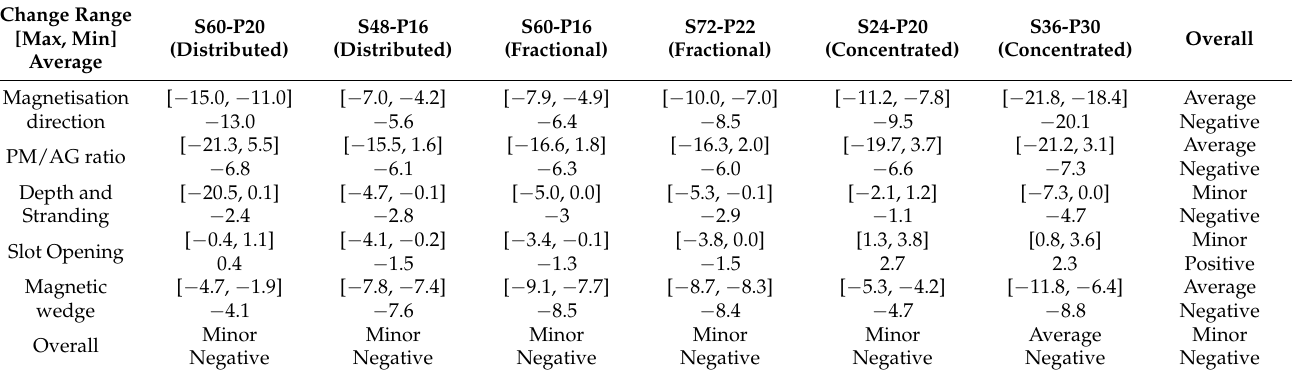
Table 11. Percentage change of output power compared to the initial design quantitative comparison for the AC loss reduction analysis